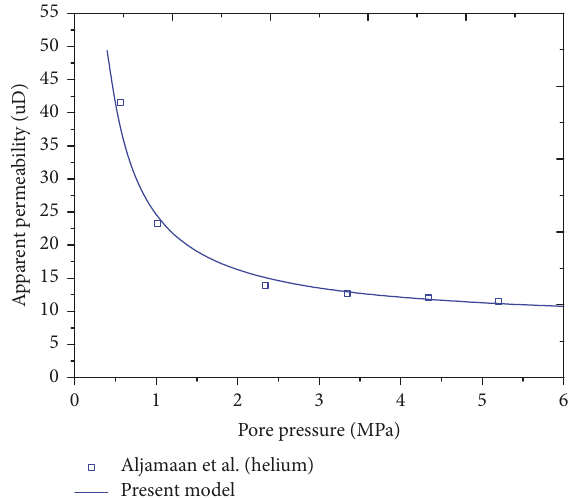
Figure 2: Comparison of the model results with the experimental data of Aljamaan et al. [35]. The solid line is calculated from (10). The parameter set is presented in Table